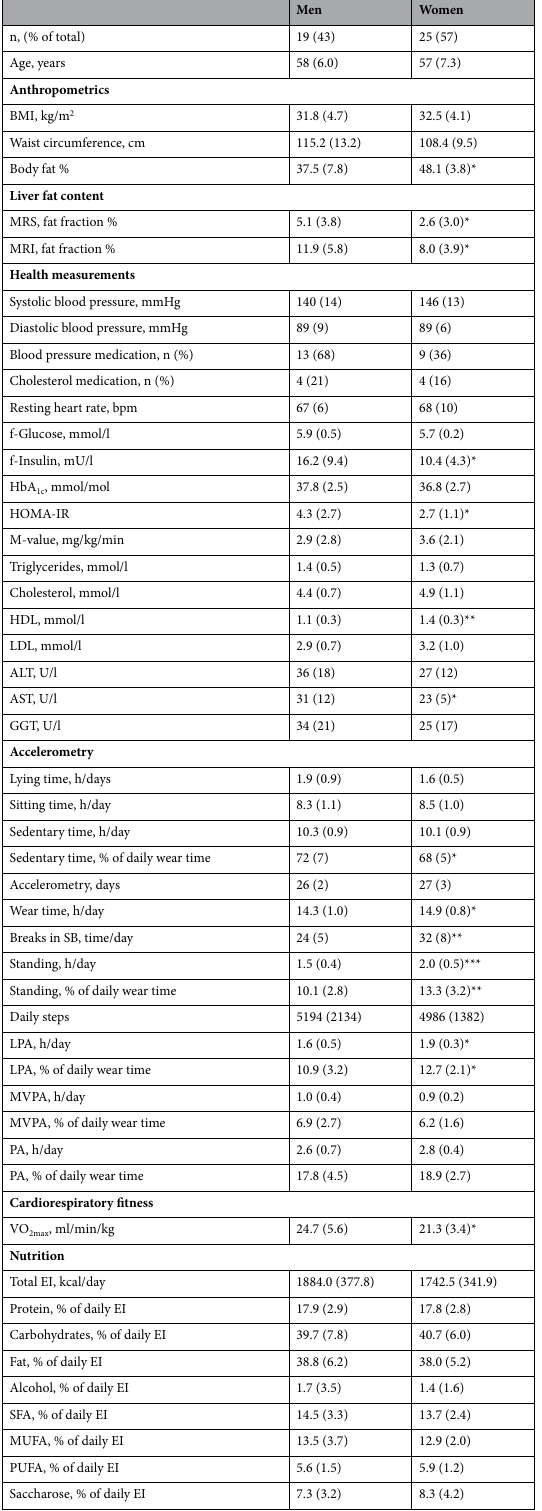
Table 2. Characteristics of the study participants by sex. If not otherwise stated, the results are reported as mean (SD). ALT alanine aminotransferase, AST aspartate aminotransferase, EI energy intake, GGT γ-glutamyltransferase, HbA 1c hemoglobin A 1c, , HOMA‑IR homeostatic model assessment for insulin resistance, f fasting, LPA light physical activity, MRI magnetic resonance imaging, MRS magnetic resonance spectroscopy, MUFA monounsaturated fatty acids, M-value whole-body insulin sensitivity, MVPA moderate to vigorous physical activity, PA physical activity (LPA + MVPA), SB sedentary behaviour (sitting + lying), SFA saturated fatty acids, PUFA polyunsaturated fatty acids, VO 2max maximal oxygen consumption. Significant p-values; *p < 0.05, **p < 0.01, ***p < 0.001, vs men. Sex difference in t-test (or Fisher’s exact test, when